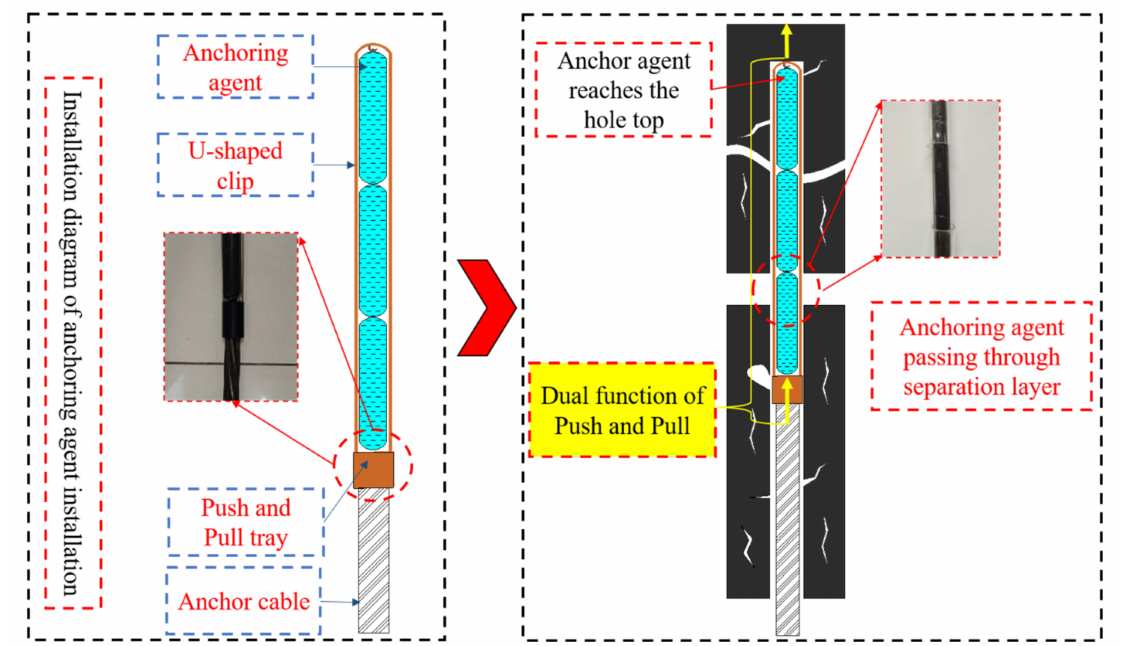
Figure 11. Effect diagram of anchorage with push and pull